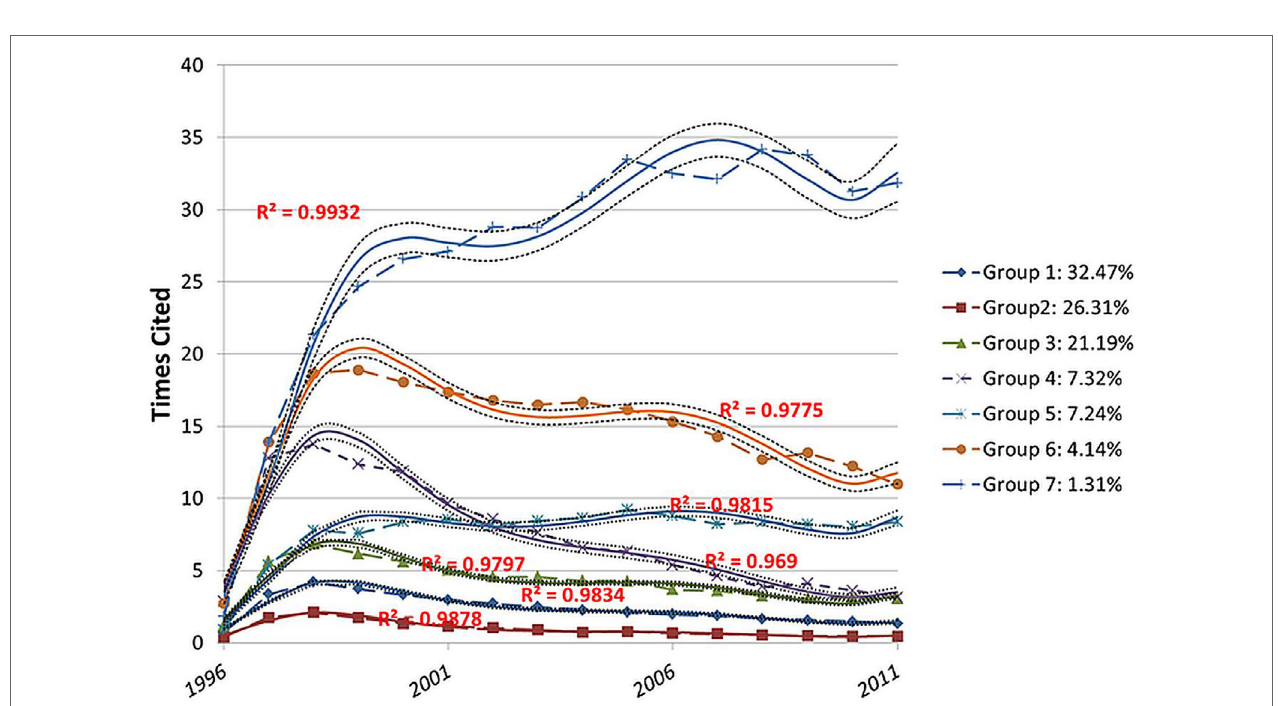
FigUre 5 | seven trajectories of 2,142 research articles published in JACS in 1996, using fifth-order polynomials . Source: Baumgartner and Leydesdorff (2014, p. 802).